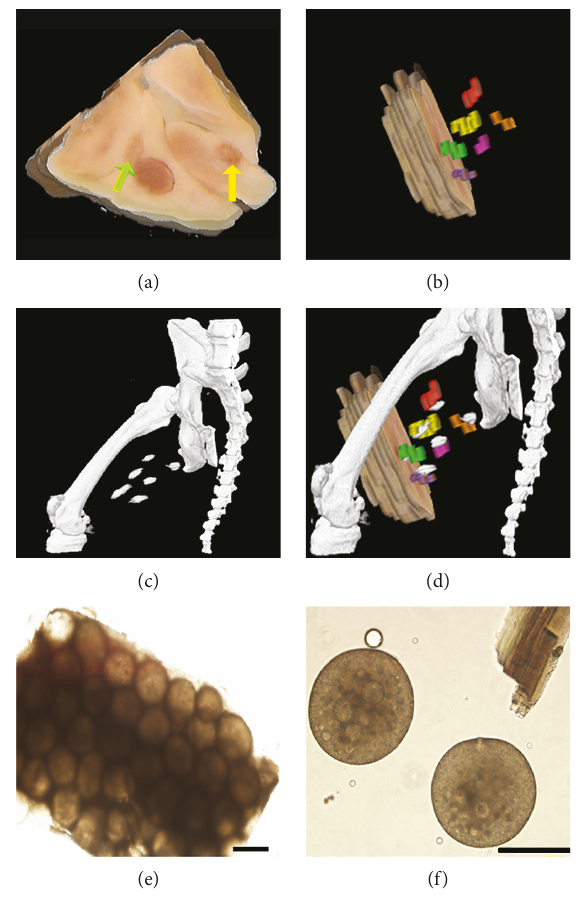
Figure 5: Ex vivo validation of PFOBCap injection sites. (a) Gross anatomical view of the rabbit medial thigh shows engrafted PFOBCaps (arrows) three days after implantation without hemorrhage or gross fi brosis. (b) Segmented injection sites with each injection show as a di ff erent color from postmortem tissue. (c) A C-arm CT image of the same rabbit demonstrates the detection of all six injections of PFOBCaps in the right thigh. (d) Fusion of C-arm CT image (c) with volume rendering of postmortem injections from (b) demonstrates high correlation of PFOBCap locations in the rabbit thigh. (e) Recovered PFOBCap injection site from rabbit medial thigh demonstrates that PFOBCaps remained intact two weeks after delivery. (f) Individual, intact PFOBCap recovered from tissue chunk two weeks after delivery. Scale bars represent 200 μ